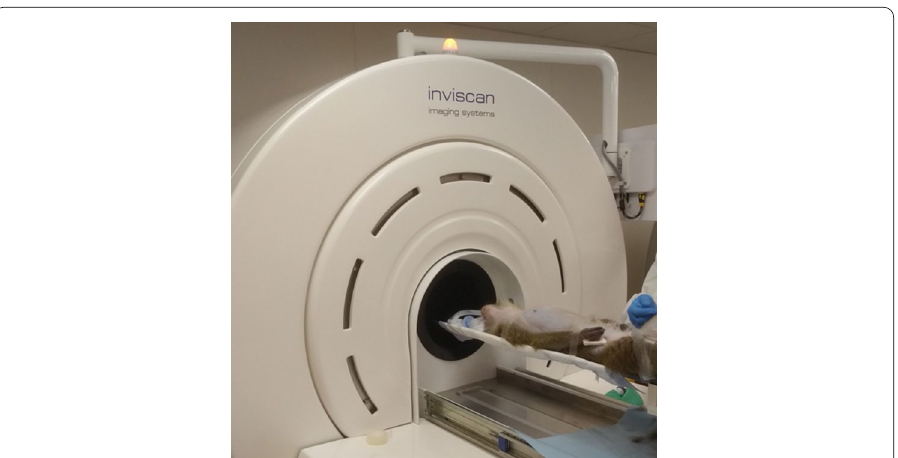
Fig. 2 Photograph of a non‑human primate experiment conducted on the IRIS XL‑220 PET/CT at the core facility for preclinical imaging of the University of Tours (Département d’Imagerie Préclinique,